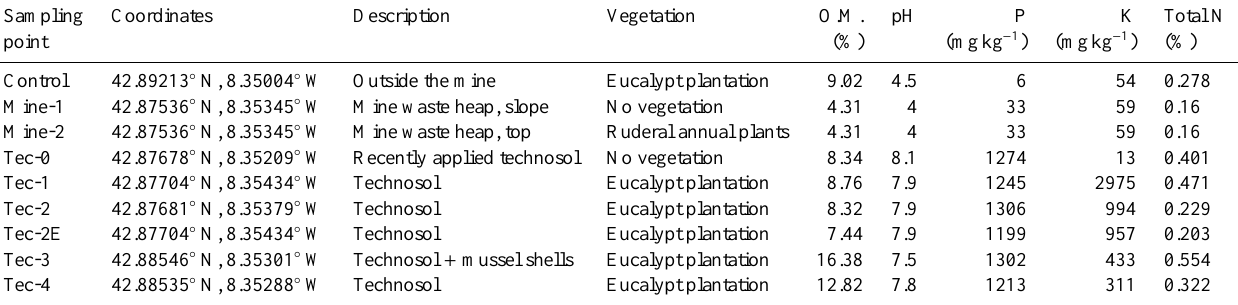
Table 1. Coordinates and description of the dominant vegetation and soil chemical parameters for the di ff erent sampling points. Sampling